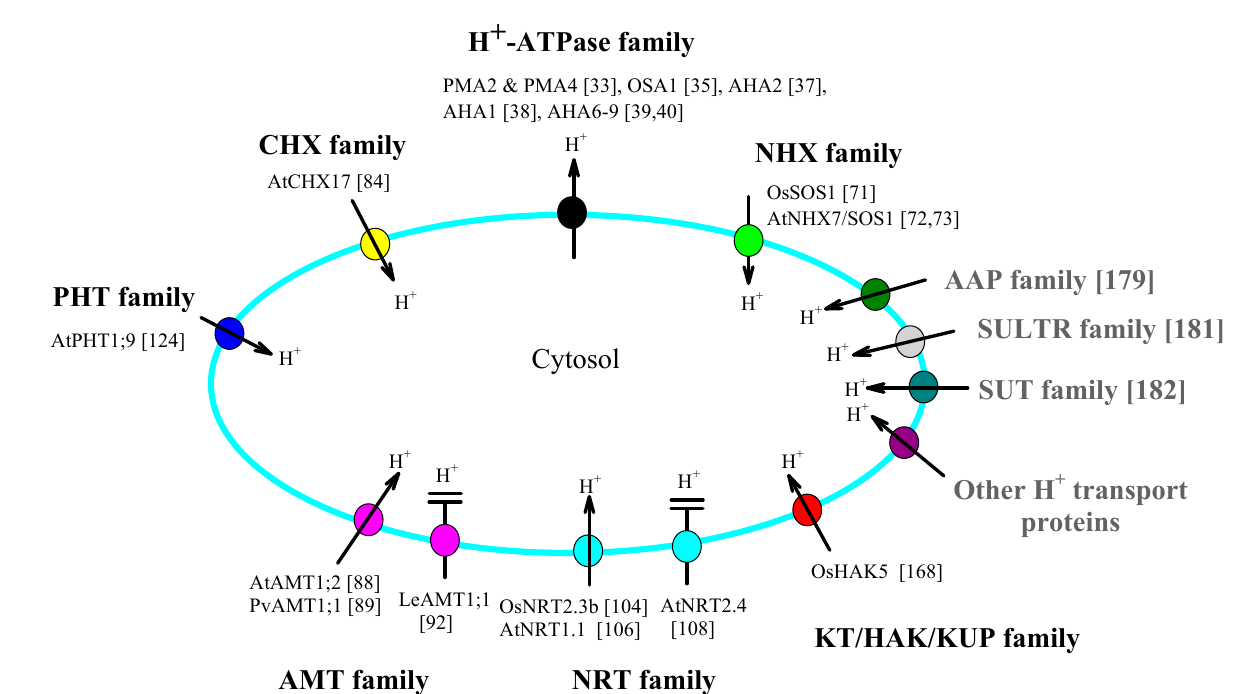
Figure 1. Plasma-membrane-located H + transport proteins. H + -ATPase family functions in mediating H + efflux from the cytosol to the extracellular space, whereas most members of the NHX, CHX, AMT, NRT, PHT, KT/HAK/KUP, AAP, SULTR, SUT family are responsible for mediating H + influx from the extracellular space to the cytosol. Notably, several intra-family members of AMT and NRT do not transport H + , indicating that not all plasma membrane transporters possess H + -coupled substrate transport mechanisms. Seven types of H + transport proteins focused on in this review (H + -ATPase, NHX, CHX, AMT, NRT, PHT, and KT/HAK/KUP) are indicated by black font, whereas other proteins (AAP, SULTR, SUT, etc.) are indicated by the gray font. Specific proteins with experimental evidences (references are indicated by [number]) are presented in the corresponding family. Arrows ( ↑ ) indicate the direction of H + flux. Inability to transport H + is indicated by special lines (symbols as shown for LeAMT1;1 and AtNRT2.4). Abbreviations: H + -ATPase (H + -pumping ATPase), NHX (Na + /H + exchanger), CHX (cation/H + exchanger), AMT (ammonium transporter), NRT (nitrate transporter), PHT (phosphate transporter), KT/HAK/KUP (K + transporter/high-affinity K + transporter/K + uptake permease), SUT (Sucrose transporter), AAP (amino acid permease) and SULTR (sulfate transporter).